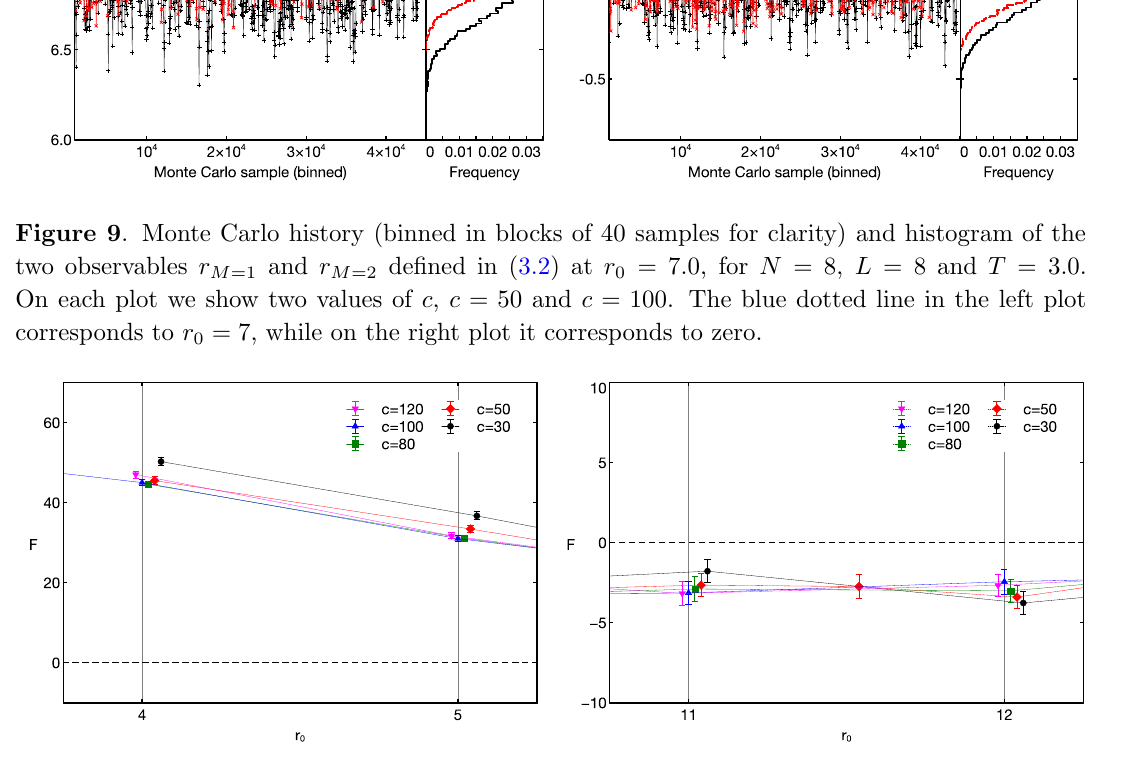
Figure 10 . Force F ( N; r 0 ; c ) = 2 c ( r 0 (cid:0) r ) measured for N = 8, L = 8 and T = 3 : 0 at two distances r 0 and (cid:12)ve values of c . When distance is small (left panel) the value of c for which the force is independent of c must be larger than c = 30. When the distance is large (right panel) all values of c that we tried are equivalent within the statistical precision of our